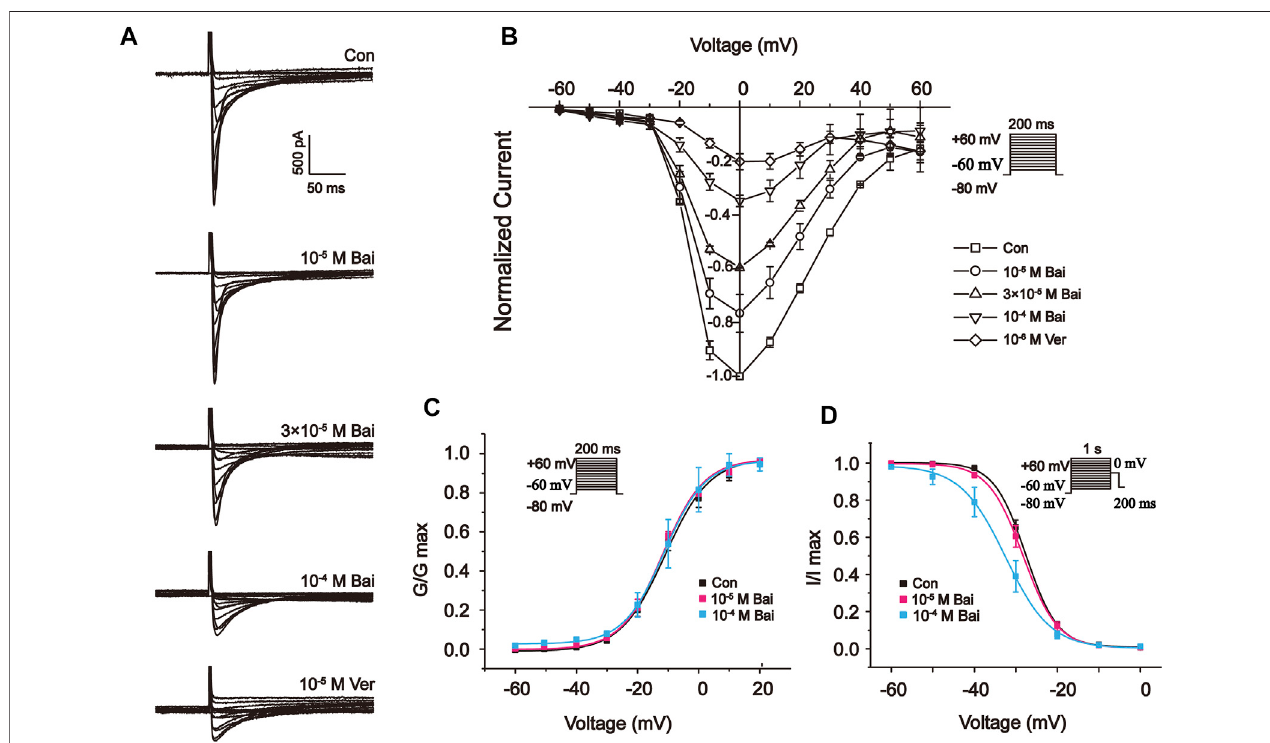
FIGURE 8 | Effects of Bai on the I-V relationship of L-type Ca 2+ currents in rat cardiomyocytes. (A) Typical traces and (B) summary data are exhibited under the applicationofCon( ),Baiat10 − 5 M( ),3×10 − 5 M( ),10 − 4 M( ),andVerat10 − 6 M( ).EffectsofBaionsteady-stateactivationandinactivationofL-typeCa 2+ currents. (C) Activation curves and (D) inactivation curves of L-type Ca 2+ currents exhibited under the application of Con and Bai at 10 − 5 M and 10 − 4 M. Values are presented as means ± S.E.M. n = 6-8